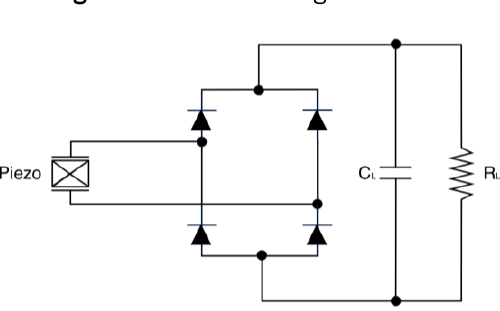
Figure 30. Diode bridge rectifier.